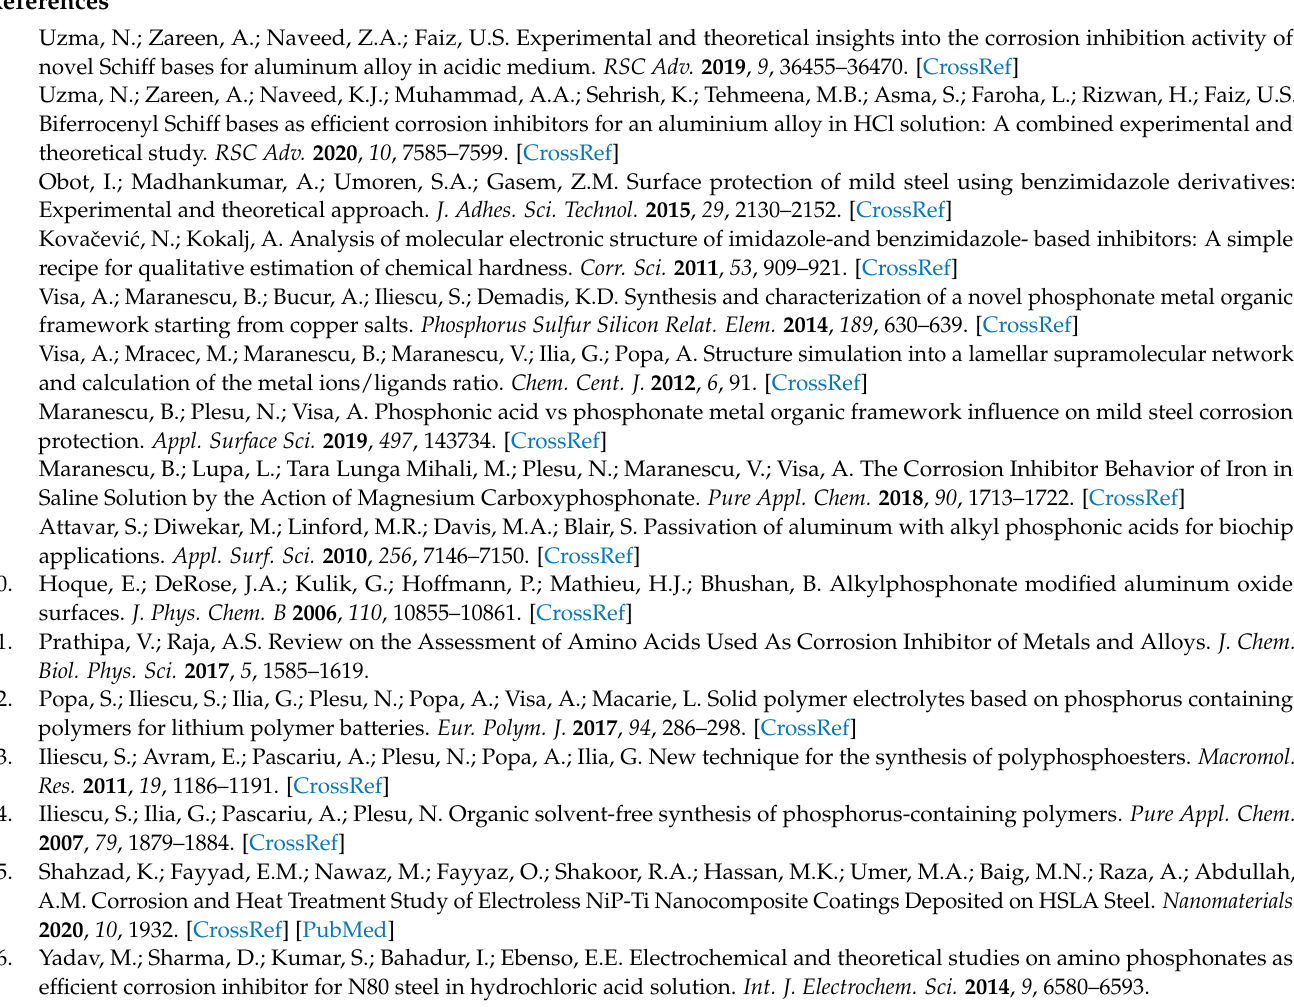
Supplementary Materials: The following are available: Figure S1. The isotherm Langmuir plots for tested inhibitors, Figure S2. Optical images for unprotected (control) and protected (by the PMG and VPA) carbon steel specimens, Figure S3. The histogram of surface roughness (a) for PMG and (b) VPA after exposure different time to NaCl 3% solution at pH = 2.3, Figure S4. The electrostatic potential and Mulliken charge distribution in PMG 3 − , Table S1. The calculated electronic properties of the deprotonated